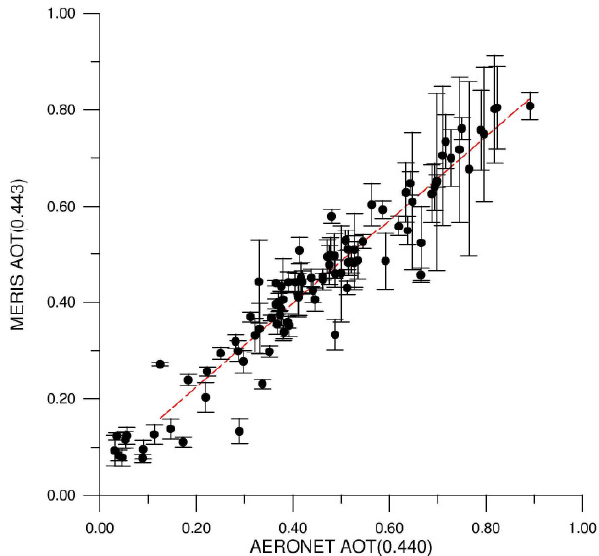
Fig. 18. Validation of BAER AOT retrievals using MERIS L1 data for the wavelength 0.443µm against AERONET channel 0.440µm for collocated data over European and US sites.